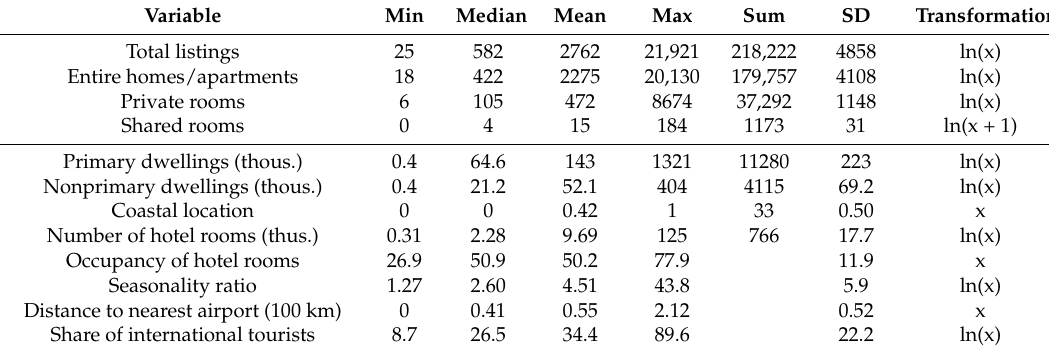
Table A3. Descriptive statistics of the variables used in models for tourist areas/sites (N = 79).